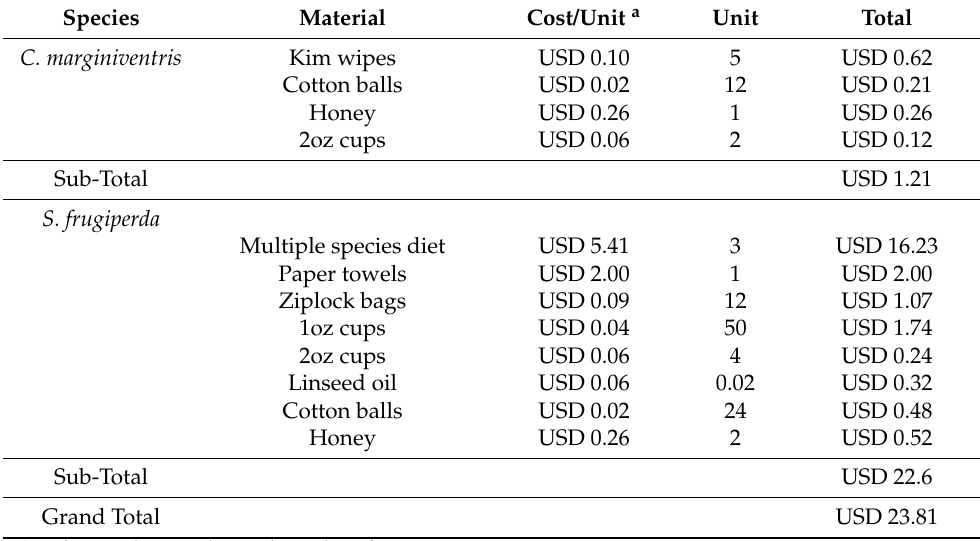
Table 4. Variable monthly expenditure for the production of 50 C. marginiventris eggs to